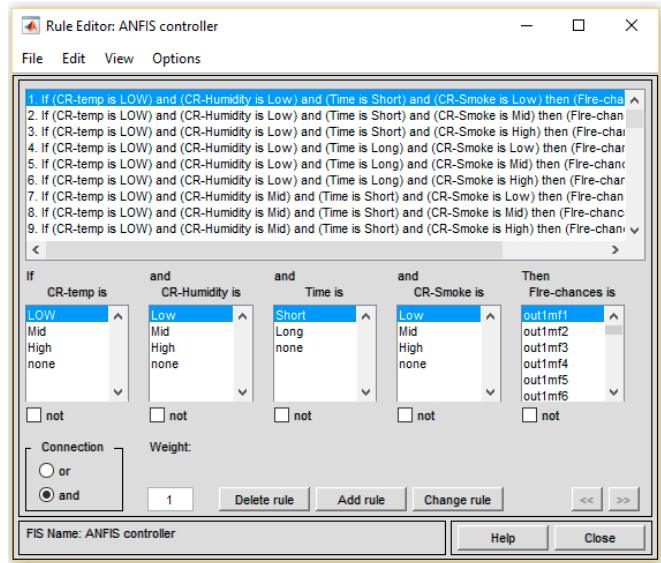
Figure 13. ANFIS generated rules.